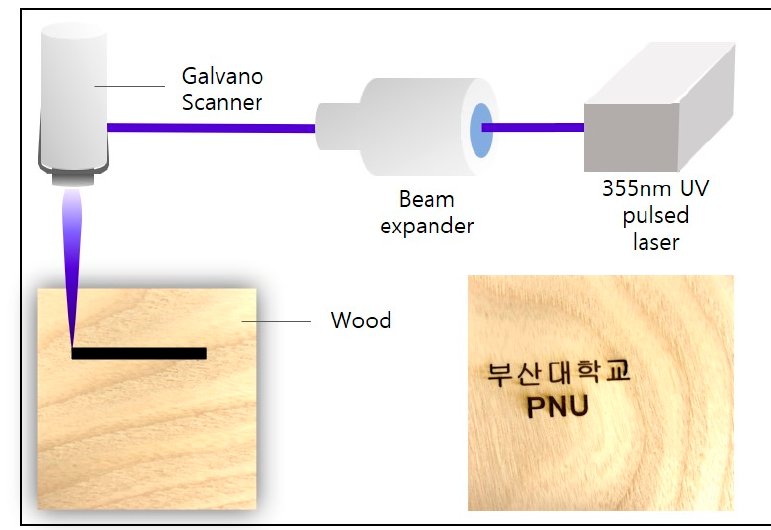
Figure 3. Schematic diagram of laser irradiated on surface of wood.